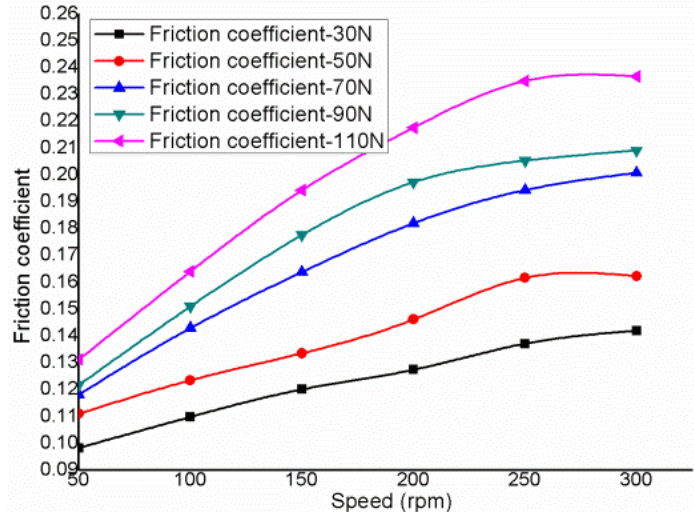
Figure 25. Friction coefficient test curve for the valve plate on CETR UMT-3. The green line repre- sents the friction coefficient under the condition of 30N. The blue line represents the friction coeffi- cient under the condition of 50N. The purple line represents the friction coefficient under the con- dition of 70N. The red line represents the friction coefficient under the condition of 90N. The black line represents the friction coefficient under the condition of 110N.